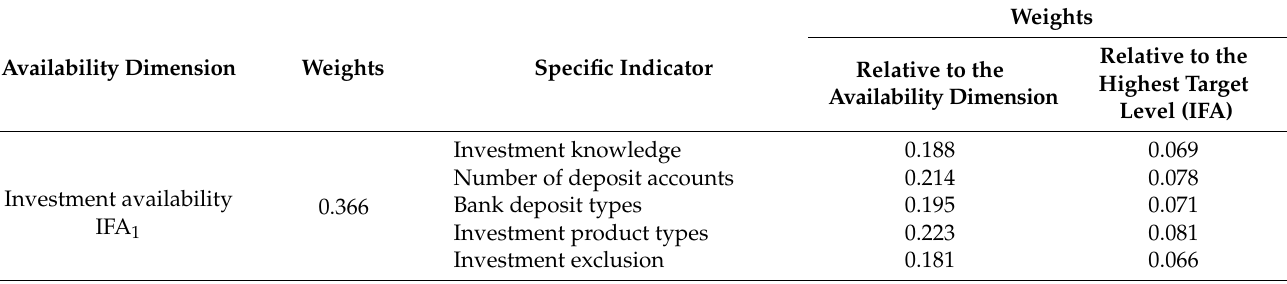
Table A2. Weight calculation results of the Cov-AHP